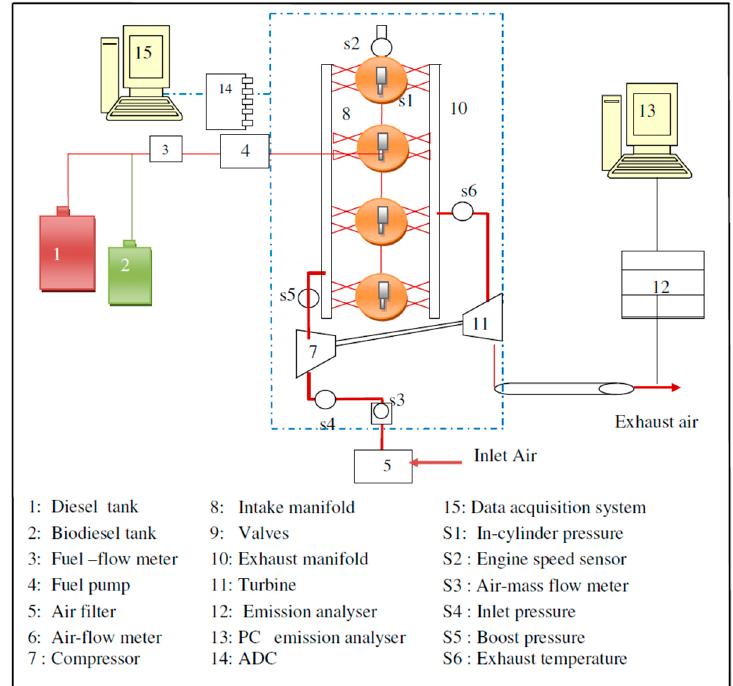
Figure 1. Experimental engine test facility layout.